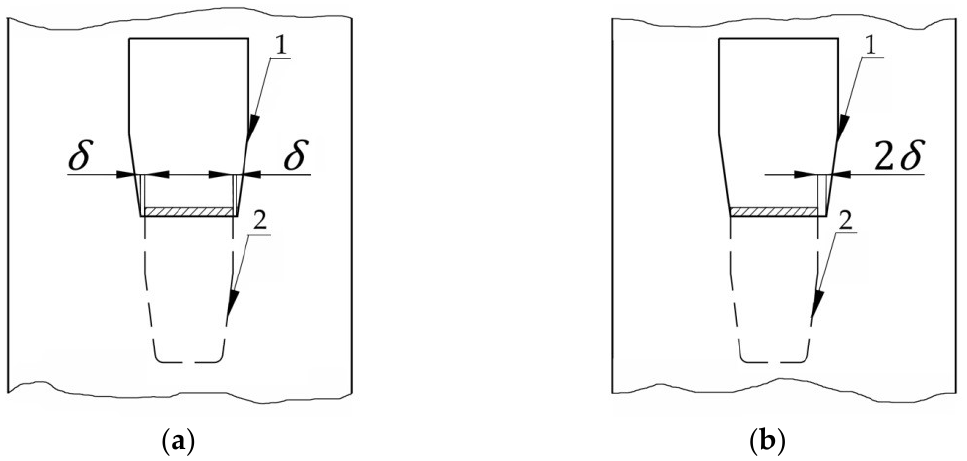
Figure 3. Looseness effect of beam end connector: ( a ) clearance between tab of the beam-end connector and upright slot; ( b ) tab of the connector will is in contact with one side of the upright slot. Note: ( 1 ) slot of the upright; ( 2 ) tab of the beam-end connector; δ is clearance.